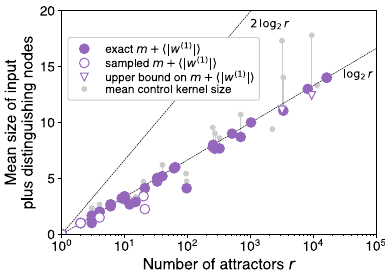
Fig. 8 First-order approximation of control kernel sizes. The fi rst-order approximation of control kernel size given by Eq. (3) is empirically less than or equal to log 2 r in all biological cases